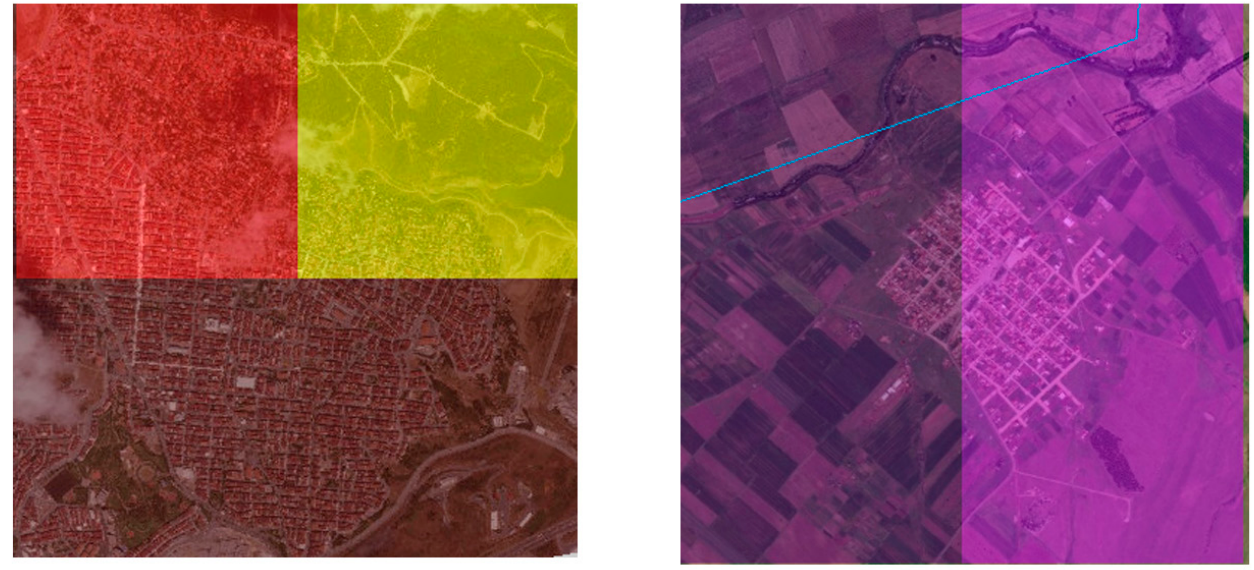
Figure 4. Grid-cells demonstrating different legend categories based on the predominance of land cover types (Source: ArcGIS).